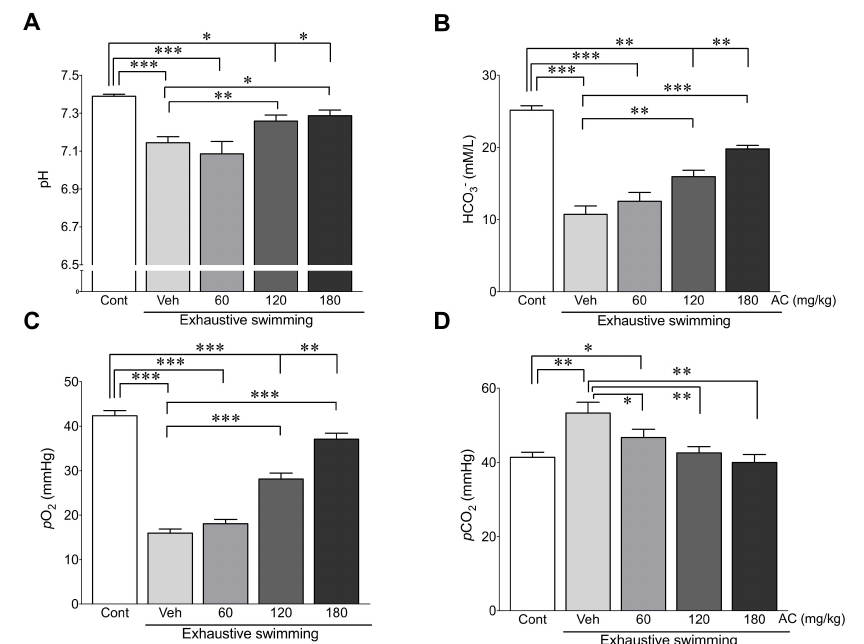
Figure 4. AC extract ameliorates metabolic acidosis due to exhaustive swimming. The blood levels of ( A ) pH, ( B ) HCO 3- , ( C ) p O 2 , and ( D ) p CO 2 were determined in rats after AC-pre-treatment for